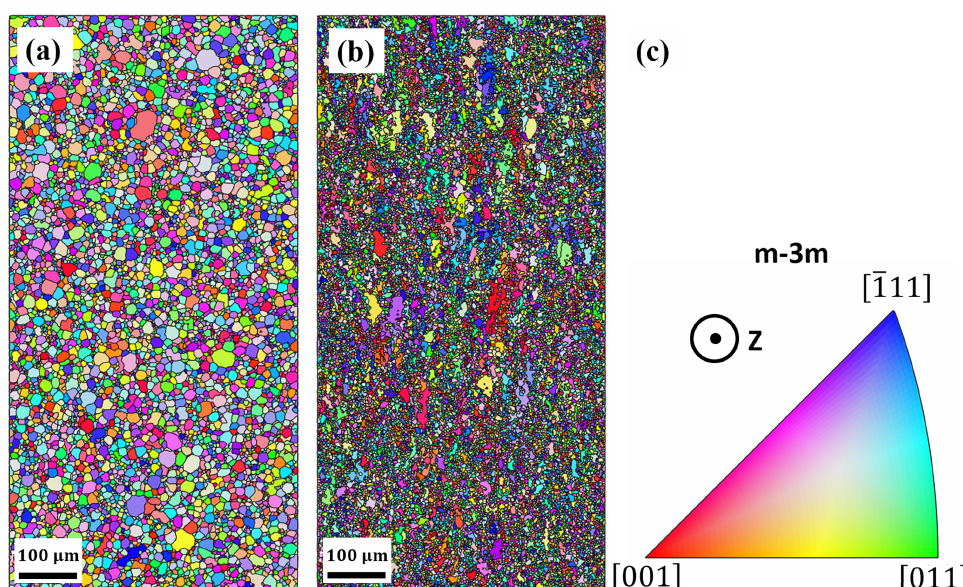
Figure 4. EBSD mean grain orientation maps with grain boundaries in solid black line of the hot- pressed pellets ( a ) LG, ( b ) SG and ( c ) the inverse pole figure [001] to indicate the cystallographic orientations.